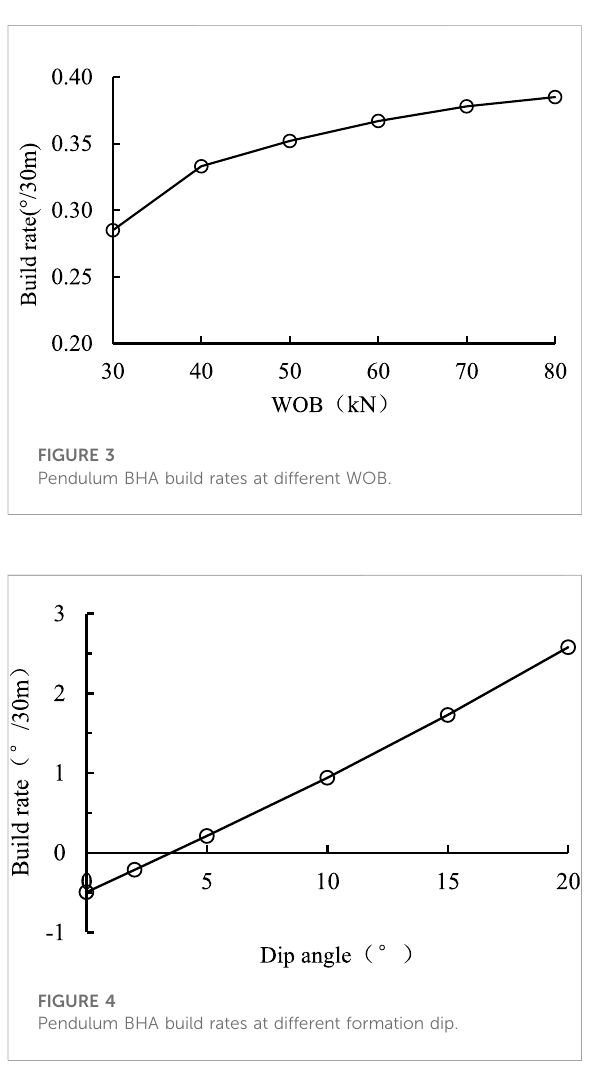
FIGURE 6 Pendulum BHA build rates with different stabilizer positions.